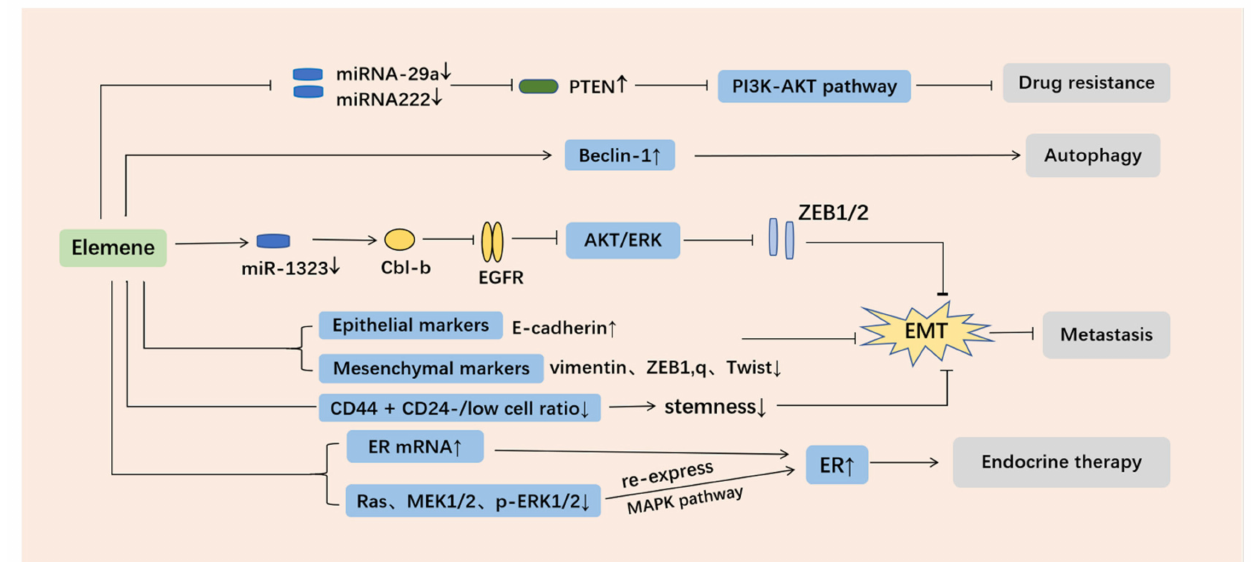
Figure 5. Mechanisms of elemene reversing multidrug resistance in tumor cells. Elemene reverses drug resistance by inducing autophagy and apoptosis, inhibiting stemness, inhibiting EMT, inhibiting tumor metastasis, and promoting endocrine therapy. Elemene induces autophagy by promoting Beclin-1. Elemene reverses drug resistance by inhibiting the PI3K–AKT signaling pathway and increasing PTEN gene expression. Elemene inhibits stemness by decreasing the CD44 + CD24 − /low cell ratio and inhibits EMT by upregulating the expression of epithelial markers and downregulating the expression of mesenchymal markers. Elemene promotes endocrine therapy by increasing the expression of ER α , increasing the expression of mRNA, and re-expressing ER α through the MAPK pathway. The symble ↑ indicates upregulated expression. The symble ↓ indicates downregulated